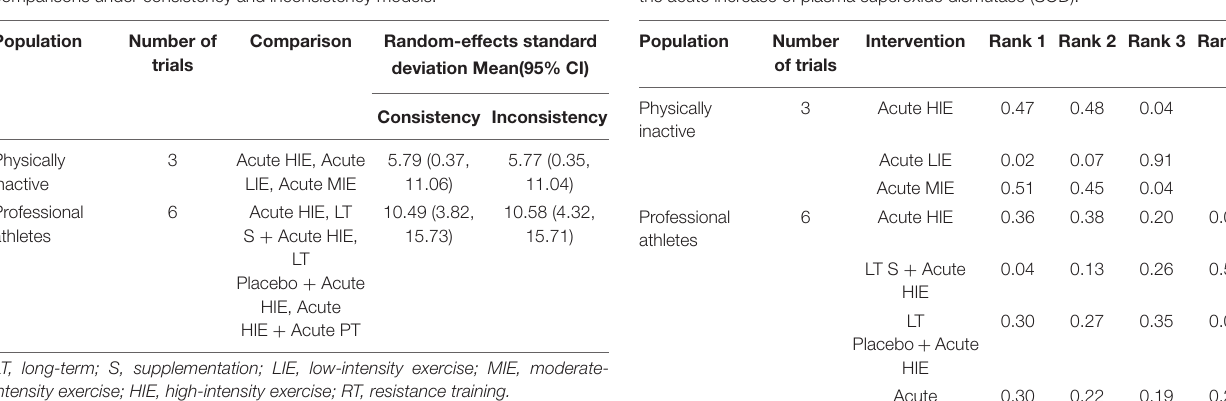
TABLE 6 | The ranking of measures and probabilities of interventions’ effect on the acute increase of plasma superoxide dismutase